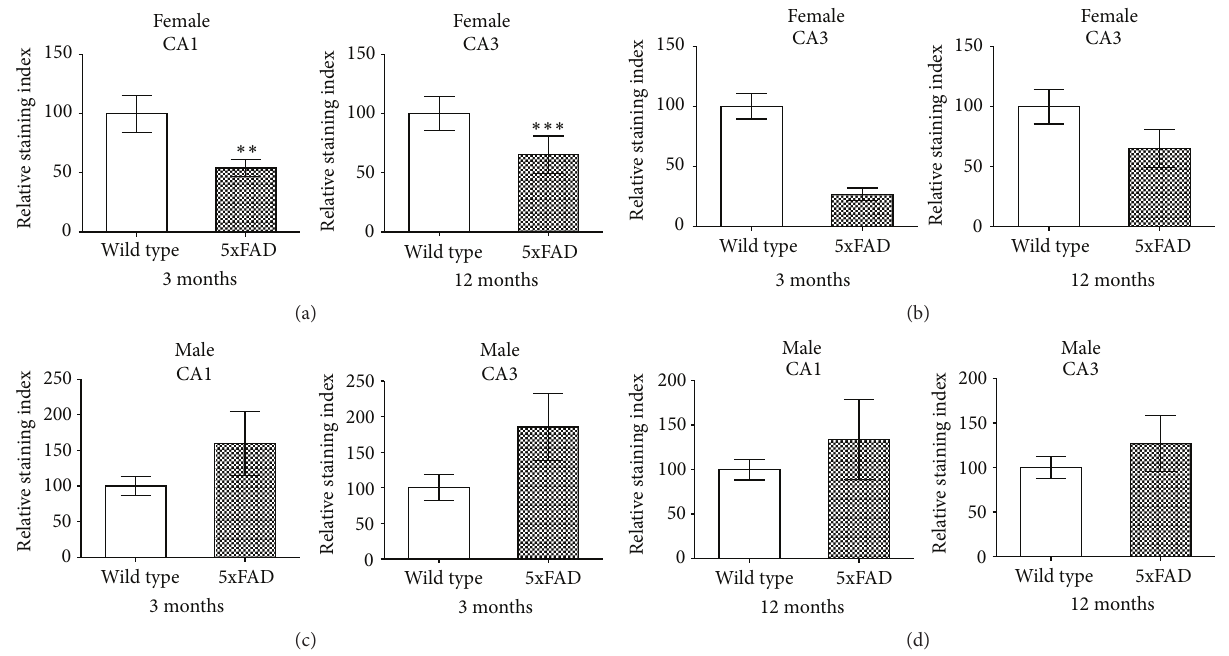
Figure 5: Young female 5xFAD mice showed less aromatase immunoreactivity than WT mice . In both hippocampal regions tested, CA1 and CA3, the relative staining index for aromatase was significantly lower in the 3-month-old female 5xFAD mice than in the WT mice (a). This difference was no longer detectable in the 12-month-old females (b). In male animals, overall the relative staining index for aromatase tended to be higher in the male 5xFAD mice; however, none of the differences was significant (c, d) ( ∗∗ 𝑝 ≤ 0.01 , ∗∗∗ 𝑝 ≤ 0.001 ; bars represent mean ± SEM, 𝑛 = 6